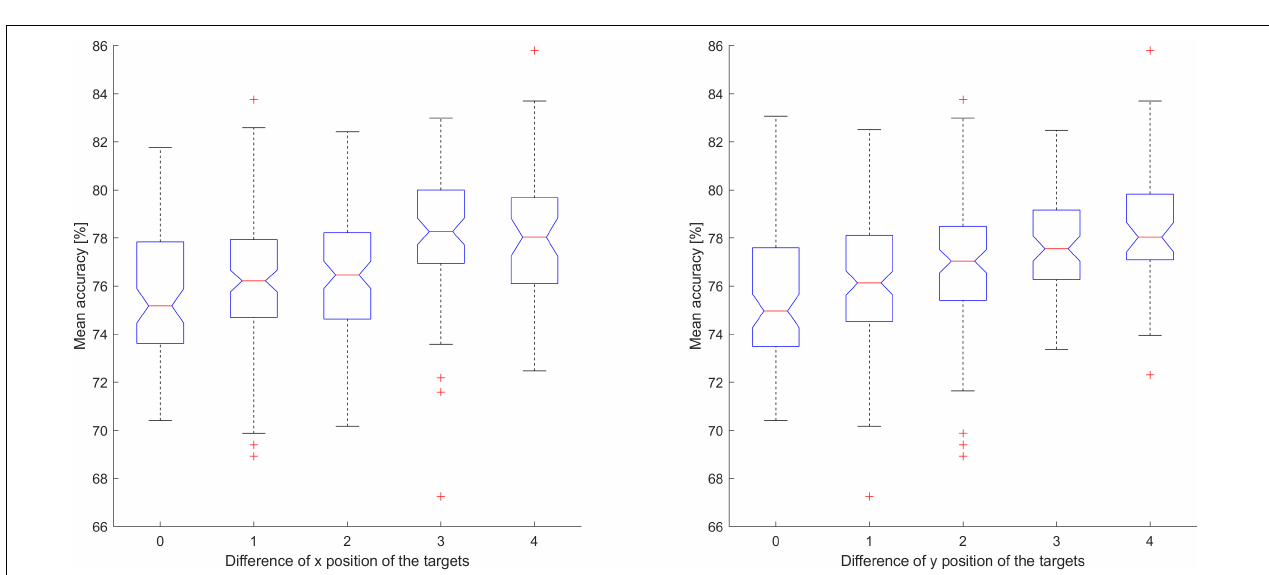
FIGURE 9 | The relationship between performance and differences in the position of the target comprising two classes when each movement was used as a different class. Performance was calculated based on the mean accuracy across all participants. If the number of features for the individual classification was 0, the classification accuracy was not included in the mean accuracy calculation. In both cases, classification accuracy tended to be higher for greater differences in position ( p < 0.01; ANOVA for both